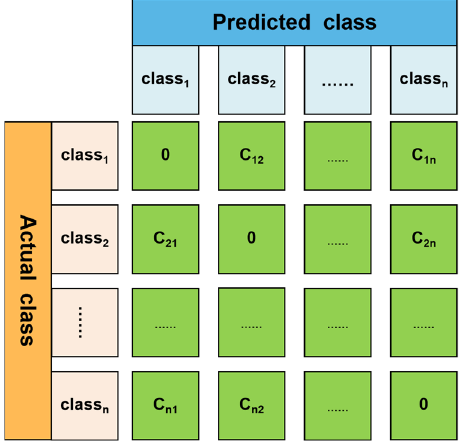
Figure 2. Schematic diagram of the cost matrix for multi-classification tasks. BT-MTS is an OVA multi-classification method, so how to calculate the corresponding cost matrix for each MTS classifier based on the known multi-classification cost matrix is a key issue in this paper. This problem can be better solved by using binary cost- sensitive error correcting output codes (BC-SECOC) [31]; the general calculation methods are as